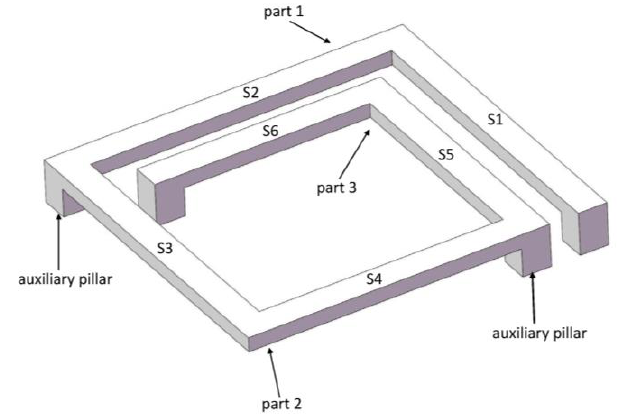
Figure 13. Schematic of MEMS suspended inductor with double auxiliary pillars.